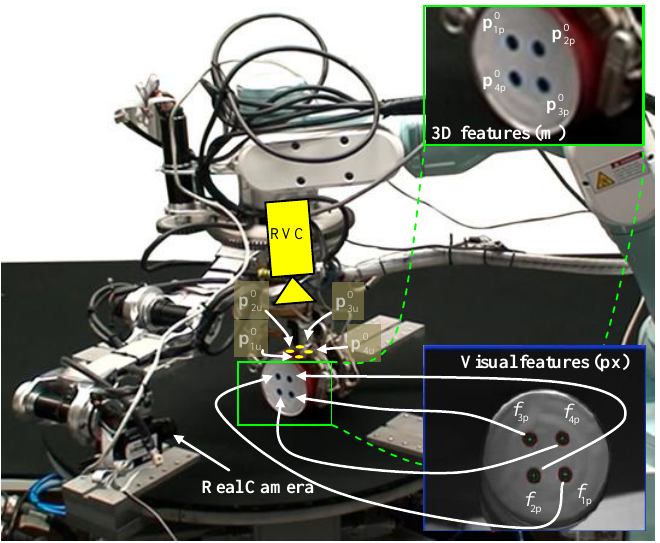
Figure 3. Reference Virtual Camera